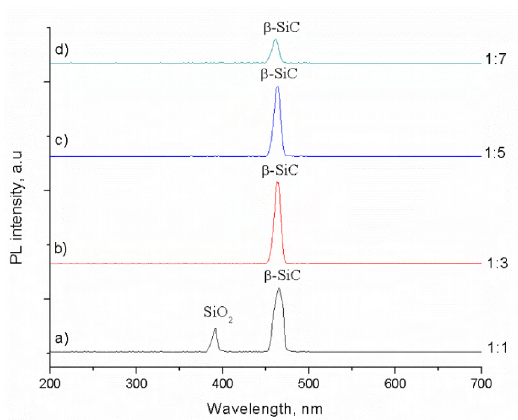
Figure 6. PL spectrum of SiCNTs synthesized from blend of SiO and MWCNTs in the ratio of a) 1:1; b) 1:3; c) 1:5 and d) 1:7. In Figure 6 (a), PL spectrum of SiCNTs synthesized from the blend of SiO and MWCNTs in the ratio of 1:1 shows the 2 presence of strong PL peak attributed to oxygen discrepancy in SiO at 387 nm and corresponded to band gaps of 3.2 2